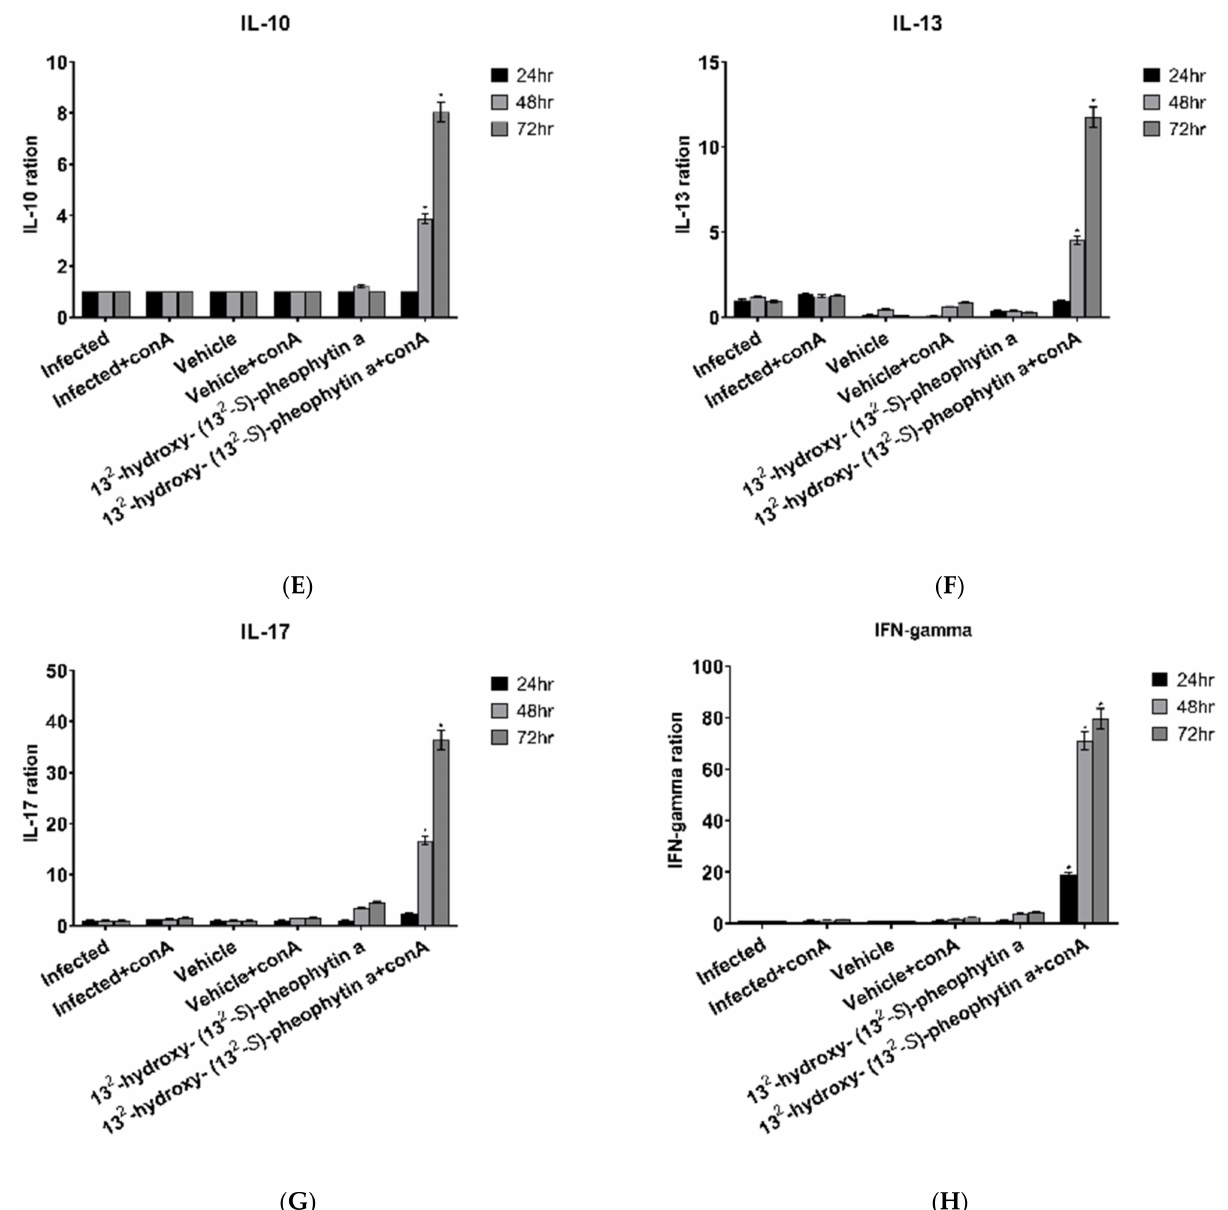
Figure 8. Cytokine production in spleen cells postinfected with H. nana for 10 days. Cell media of spleen cells were harvested to determine IL-2, IL-4, IL-5, and IL-6 after 24, 48, and 72 h incubation. Infected group: male BALB/c mice infected by H. nana without treatment in vivo. Vehicle and 13 2 -hydroxy- (13 2 -S)-pheophytin a group: infected groups were treated with vehicle or 13 2 -hydroxy- (13 2 -S)-pheophytin a at 0.025 g/kg/day for 10 days in vivo. Con A: spleen cells were cultured with concanavalin A. IL-2, IL-4, IL-5, and IL-6 ratios are shown at 24, 48, and 72 h of incubation ( A – D ). * p < 0.05 indicates a statistical significance from infected + con A. Cytokine production in spleen cells postinfected with H. nana for 10 days. Cell media of spleen cells were harvested to determine IL-10, IL-13, IL-17, and IFN- γ after 24, 48, and 72 h incubation. Infected group: male BALB/c mice infected by H. nana without treatment in vivo. Vehicle and 13 2 -hydroxy-(13 2 -S)-pheophytin a group: infected groups were treated with vehicle or 13 2 -hydroxy-(13 2 -S)-pheophytin a at 0.025 g/kg/day for 10 days in vivo. Con A: spleen cells were cultured with concanavalin A. IL-10, IL-13, IL-17, and IFN- γ ratios are shown at 24, 48, and 72 h of incubation ( A – H ). * p < 0.05 indicates a statistical significance from infected + con